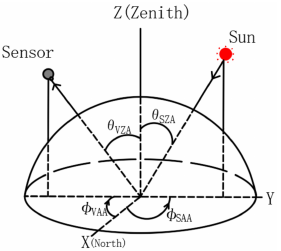
Figure 3. The schematic diagram of “illumination-viewing” geometry by θ VZA (view zenith angle), θ SZA (solar zenith angle), Φ VAA (view azimuth angle), and Φ SAA (solar azimuth angle), and the principal plane ( Φ VAA = 0 ◦ or − 180 ◦ ), cross-principal plane ( Φ VAA = 90 ◦ or − 90 ◦ ), along-row plane ( Φ VAA = 30 ◦ or − 120 ◦ ), and cross-row plane ( Φ VAA = 120 ◦ or − 60 ◦ ) for collecting field observations. (Note: Positive VZA represents forward, and negative represents backward; azimuth angle of 0 ◦ is defined as the